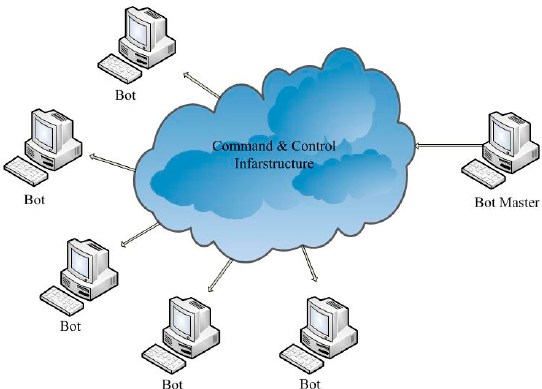
Figure 1. Structure of a typical botnet.